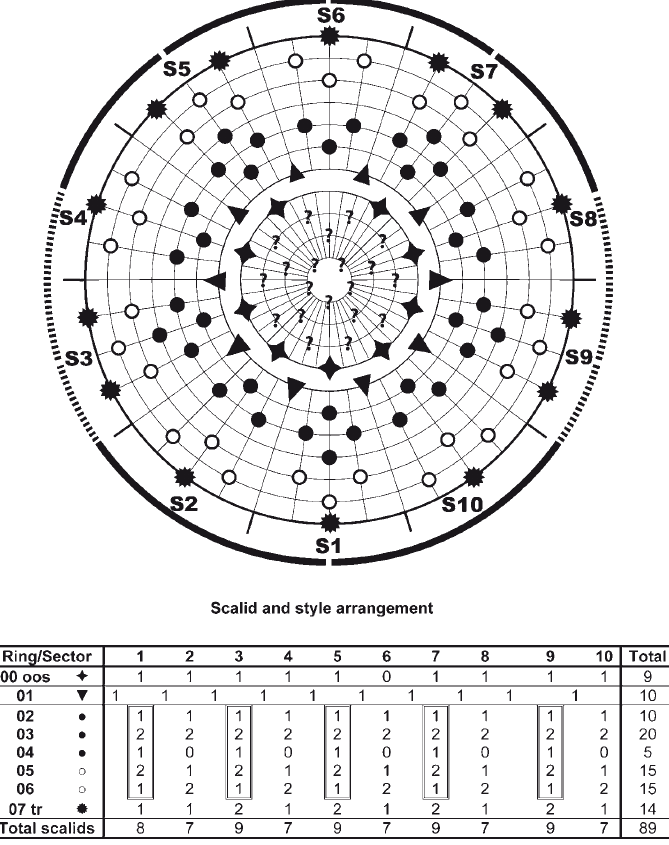
F ig . 13. – Diagram of mouth cone, introvert and placids in Pycnophyes smaug n. sp. with the distribution and type of scalids by ring and sector. Dashed lines mark flexible cuticular lateral areas. “Double diamonds” are marked in the table with double lines. oos outer oral